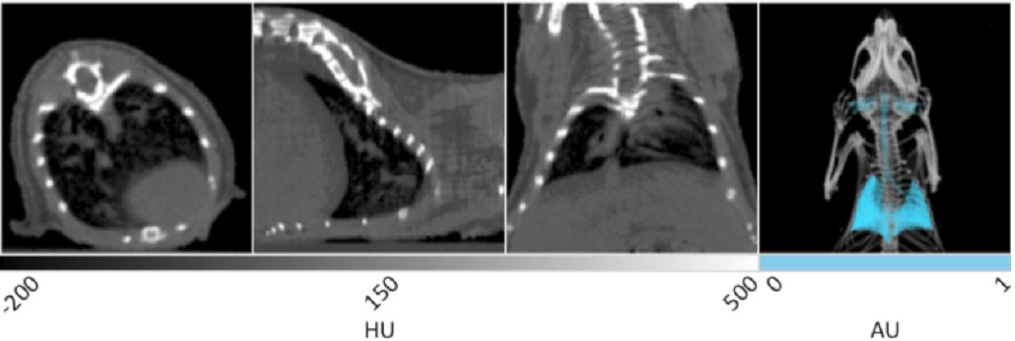
Figure 1. X-ray CT data of murine lungs. The first three panels display transverse, sagittal, and coronal slices of healthy lung tissue. The lung air space is noted as darker volumes due to its low density relative to the surrounding tissue. The fourth panel is a 3D rendering of the same data with the lungs false colored cyan to aid